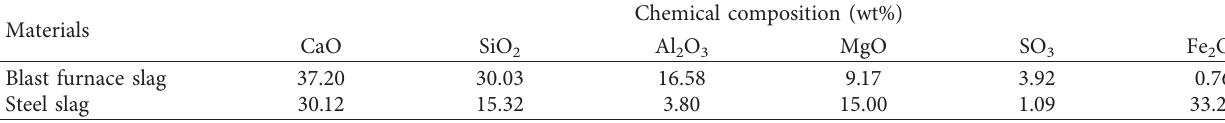
Table 1: Chemical composition of blast furnace slag and steel slag.